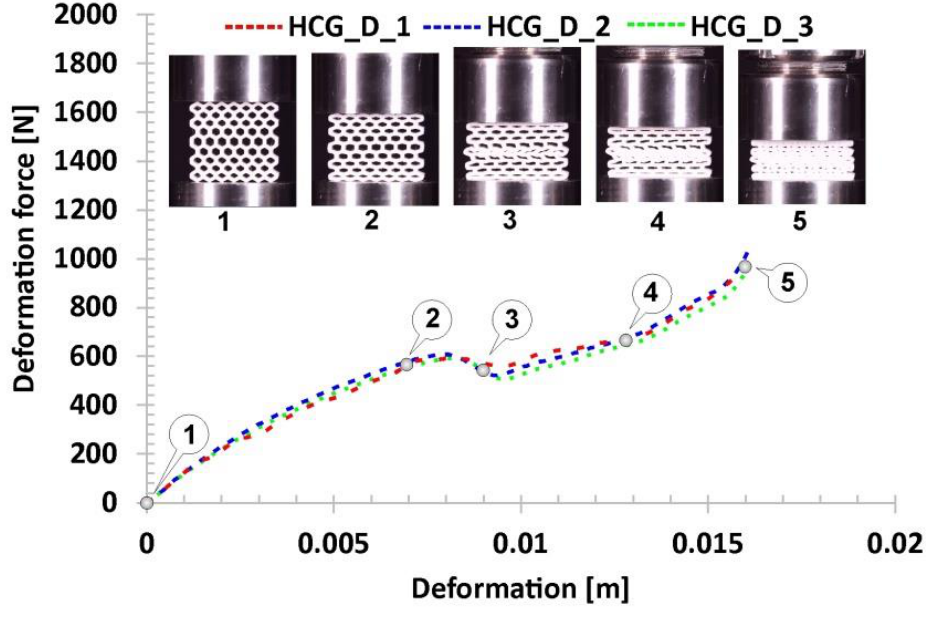
Figure 14. The results of the compression tests of the structural specimen with gradually decreasing honeycomb topology.